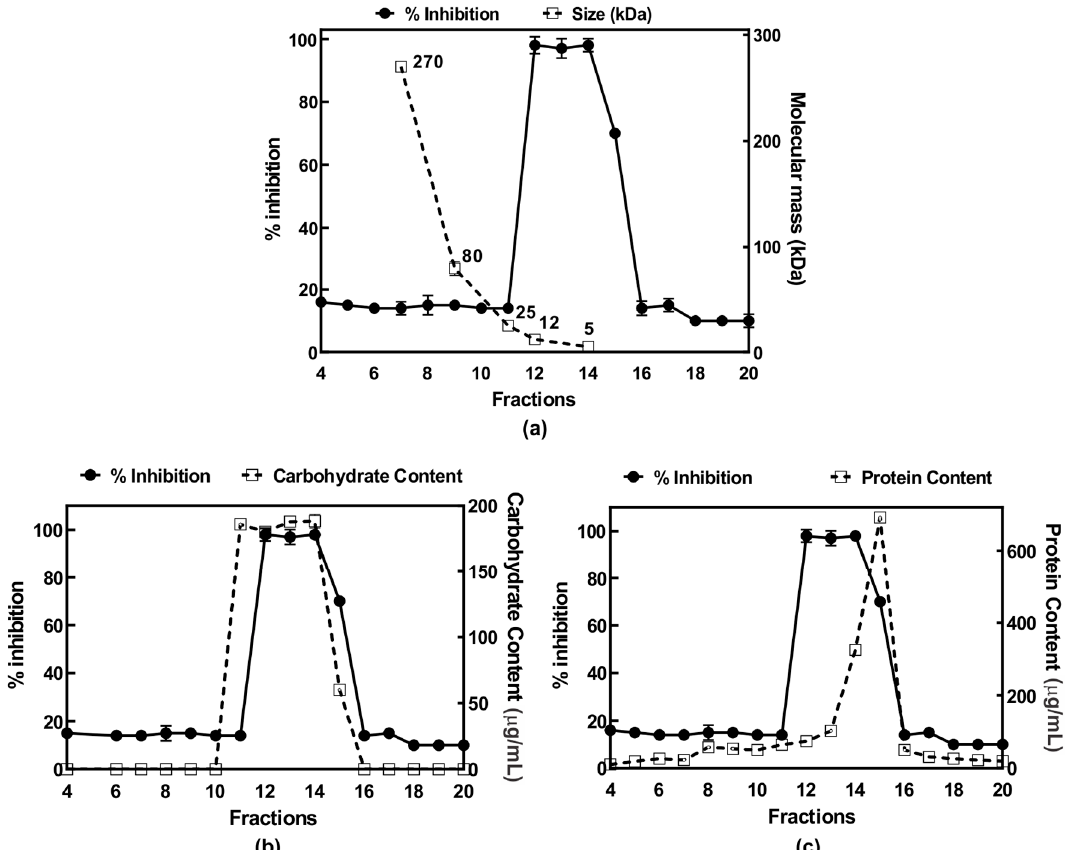
Figure 3. Purification of the anti-inflammatory polysaccharide from Echinodontium tinctorium (AIPetinc) using Superdex 200. Fractions collected were assessed for anti-inflammatory activity where percent inhibition represents the inhibition of LPS-induced TNF- α plotted against ( a ) dextran standards, ( b ) carbohydrate contents, and ( c ) protein contents. Results are representative from two separate experiments ( n = 2).